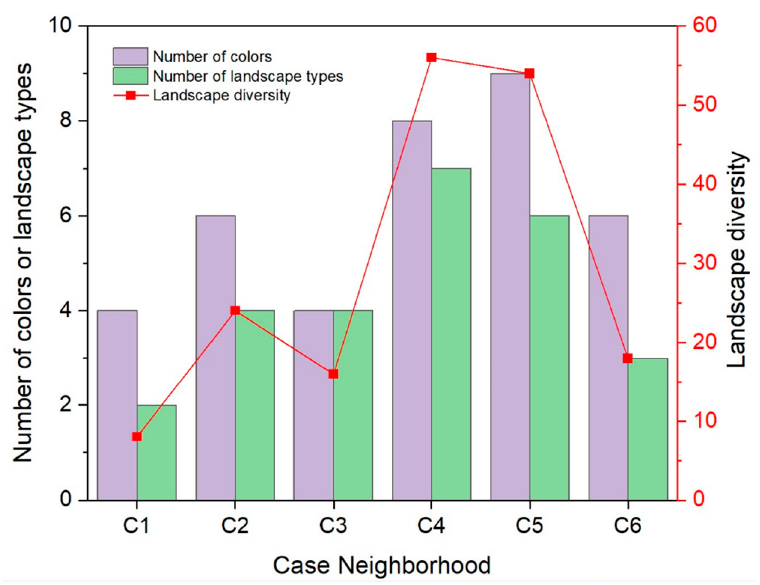
Figure 6. Landscape diversity and its parameters of the six case neighborhoods.